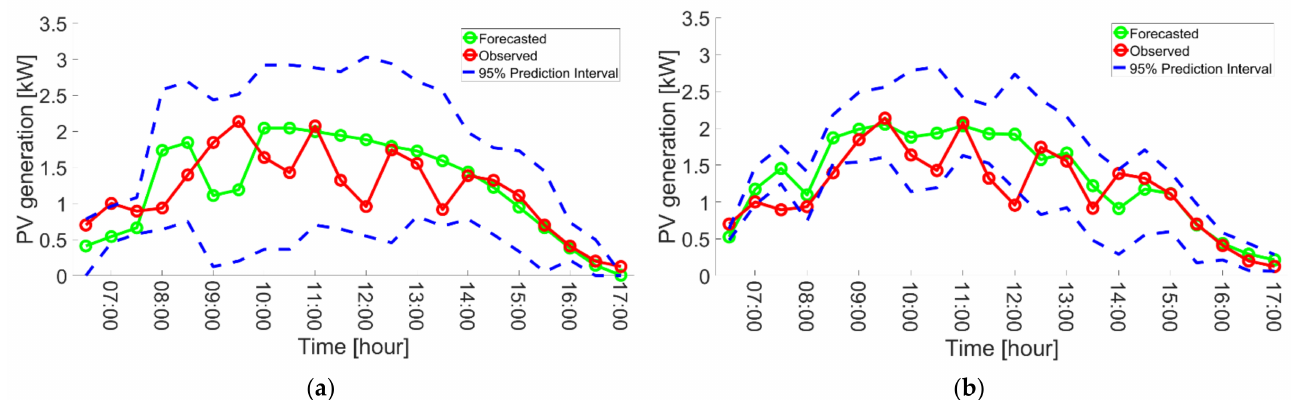
Figure 8. Deteriorating of forecasted PV generation for PV (iii) on 15 July 2014. The day has the worst PI coverage rate by the multiple PV forecast model among 30 days. ( a ) Single PV forecast model for PV (iii) (Cover rate = 90%). ( b ) Multiple PV forecast model for PV (iii) (Cover rate = 77%).